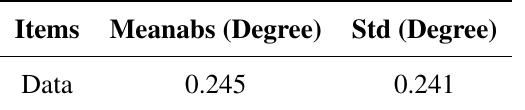
Table 6. The data features of